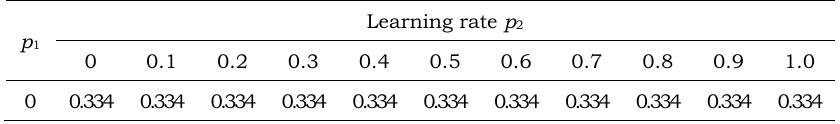
Learning rate p